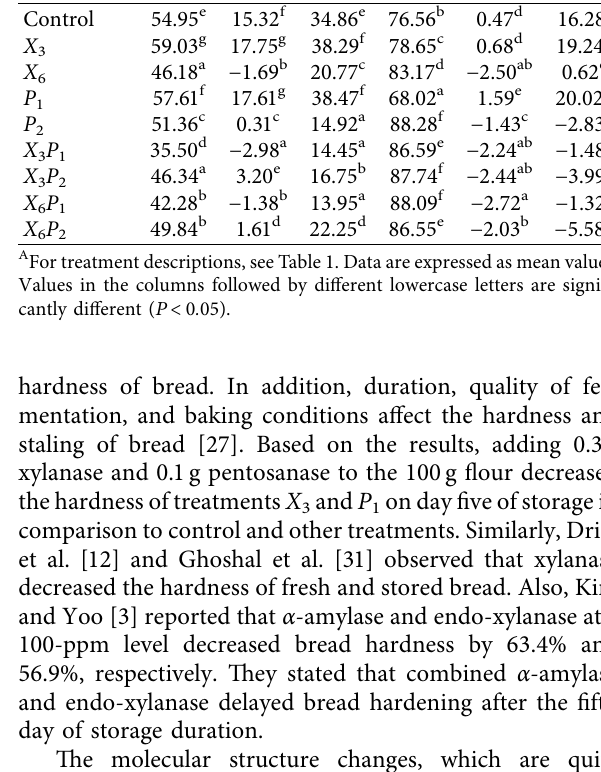
Table 6: The crust and crumb color of baguette bread samples.